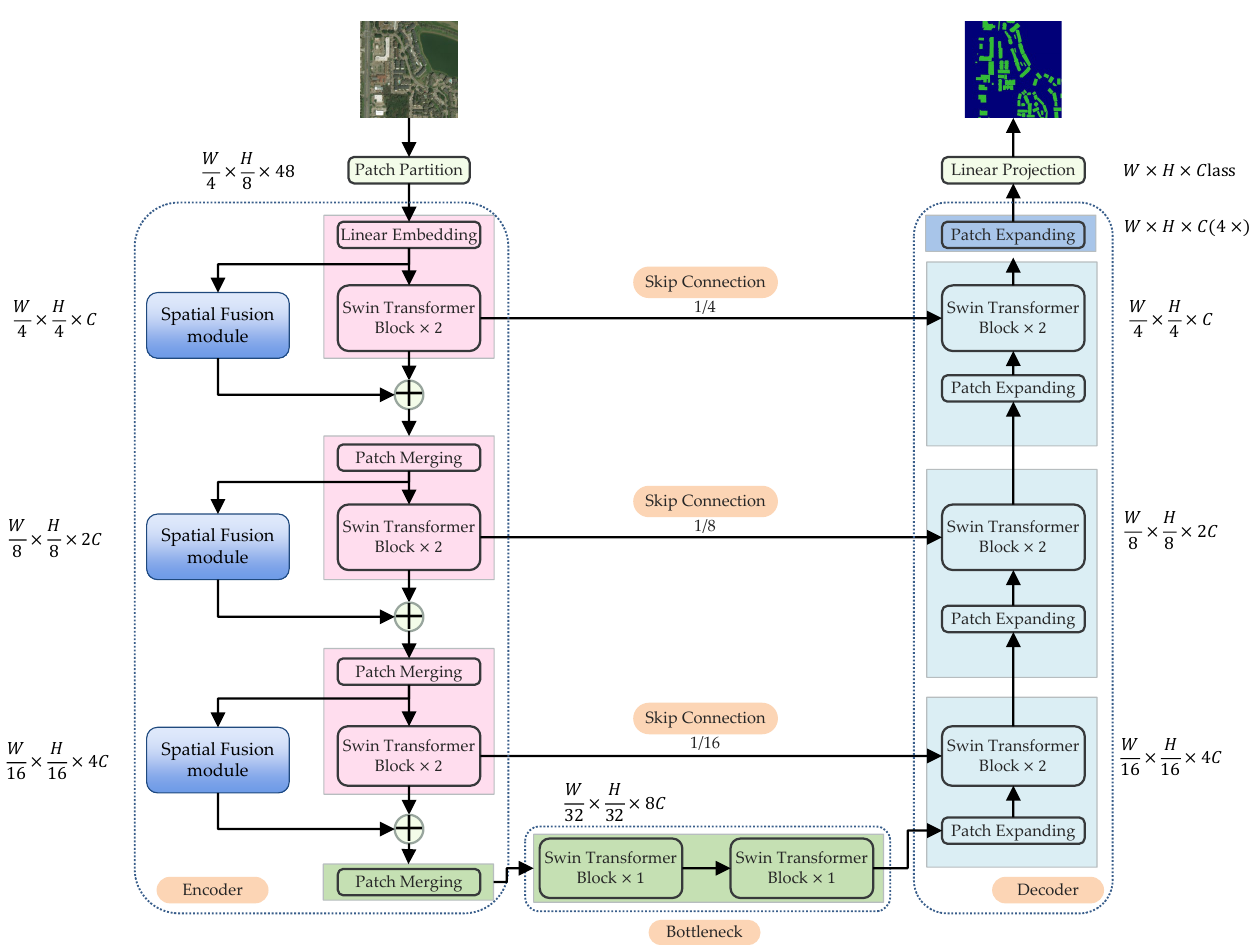
Figure 2. The architecture of U-Net-like network based on Swin Transformer block, which is com- posed of encoder, bottleneck, decoder and skip connections. Spatial fusion modules are embedded in the